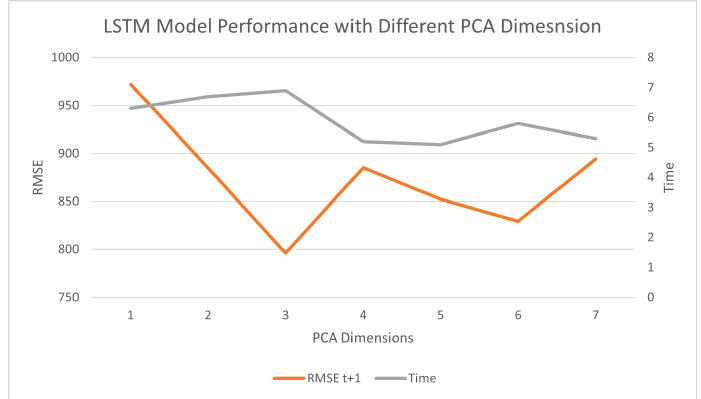
Figure 8. LSTM model performance with different PCA dimensions.